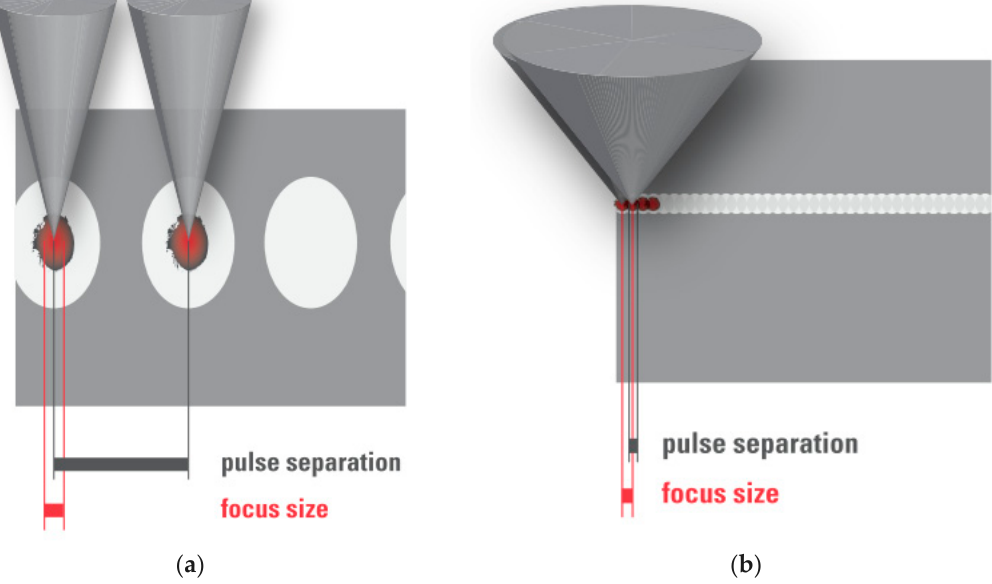
Figure 4. ( a ) High pulse energy, low repetition rate (large spot separation); ( b ) low pulse energy, high repetition rate (small spot separation, overlapping plasma effects of spots).